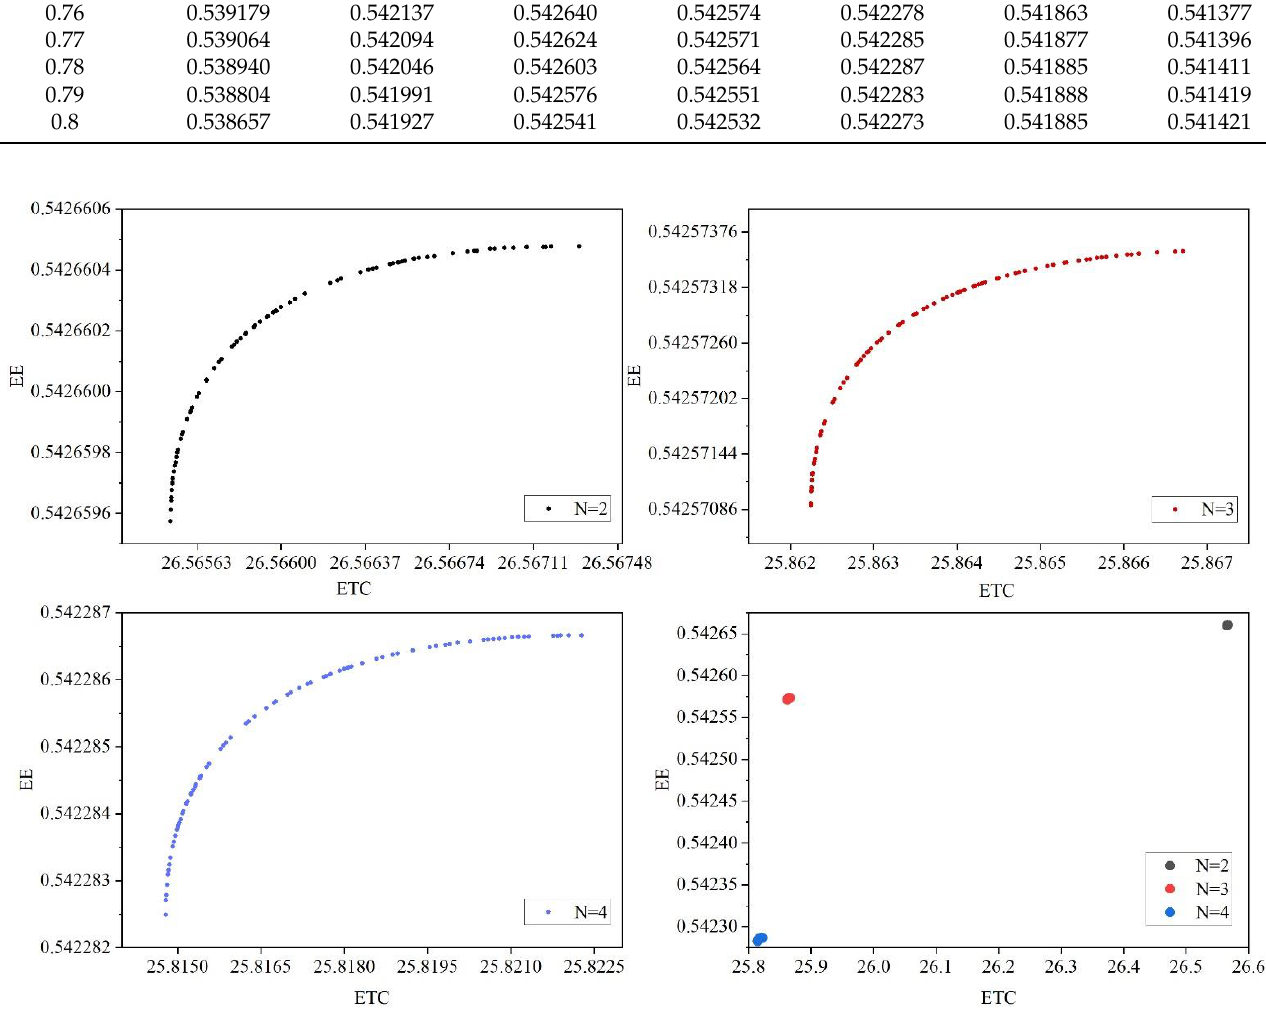
Figure 7. Pareto curve at different N .